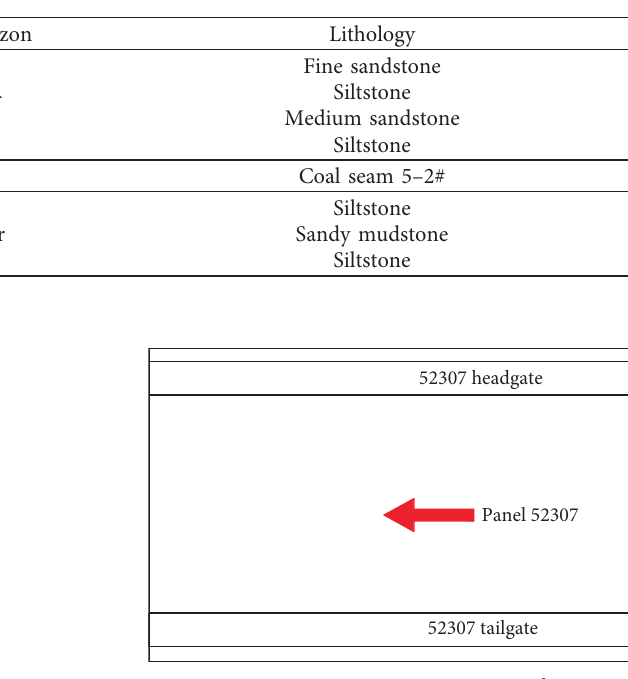
Figure 4: Diagram of pressure gauge